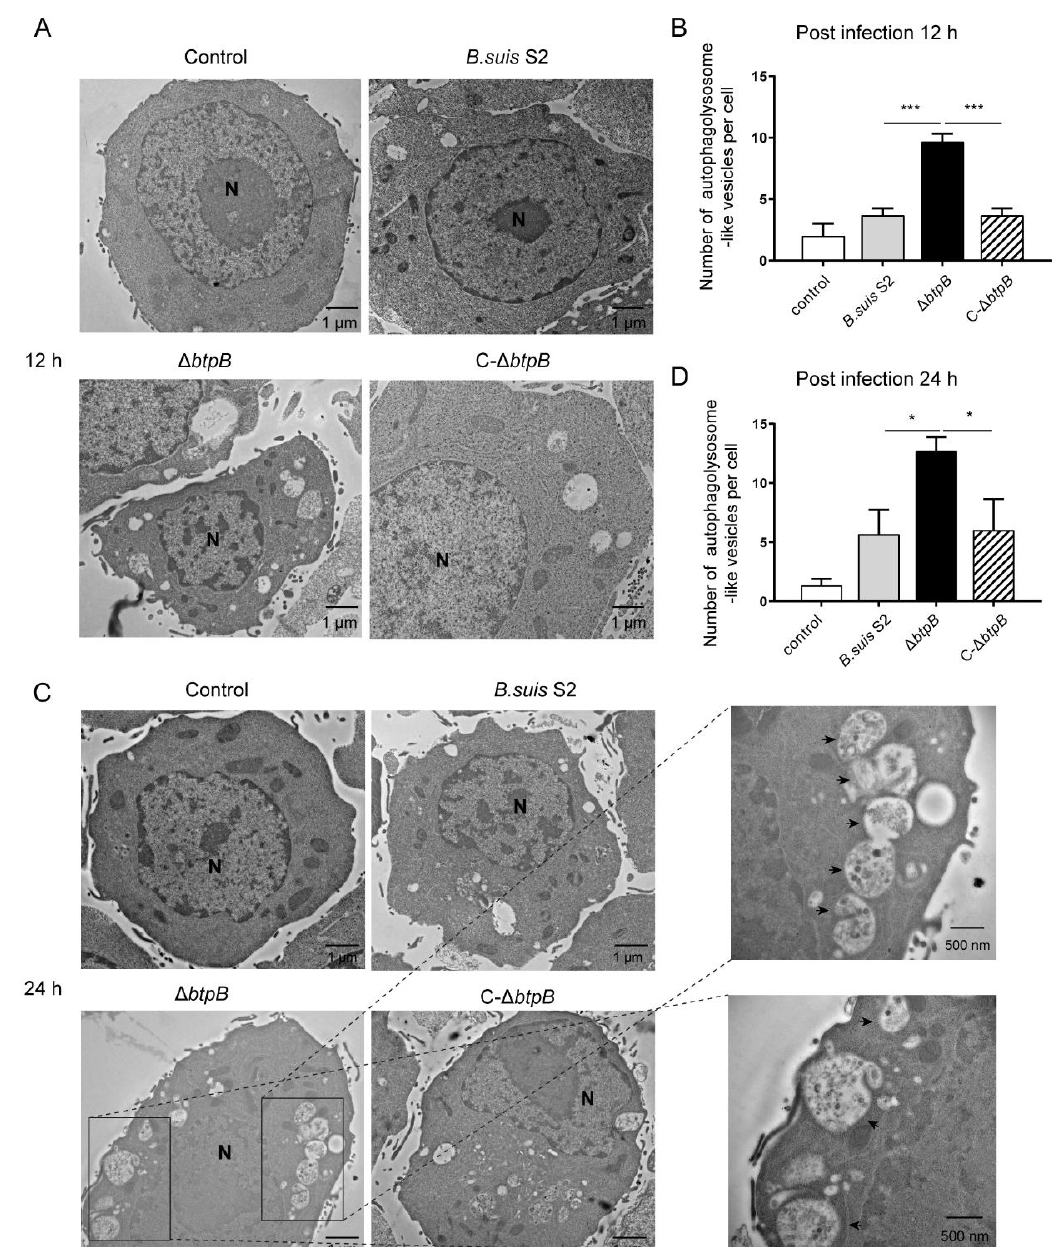
Figure 4. BtpB inhibits autophagolysosome formation during Brucella infection. ( A , C ) RAW264.7 cells were infected with Brucella strains (MOI = 200) for 12 and 24 and samples were imaged by transmission electron microscopy. N, nucleus; black arrowheads indicate autophagolysosomes. Scale bars, 1 µ m. ( B , D ) Quantification was made according to the average number of autophagolysosomes per cell. Data represent mean ± SD, as analyzed by one-way ANOVA and Bonferroni multiple comparison test. * p < 0.05; *** p <